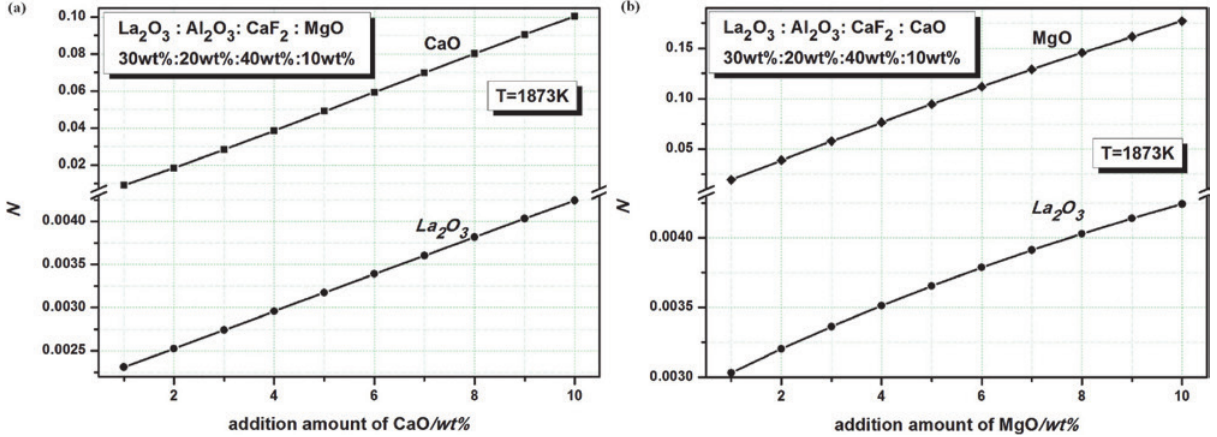
Fig. 5: The influence of CaO and MgO content on mass action concentration of La 2 O 3